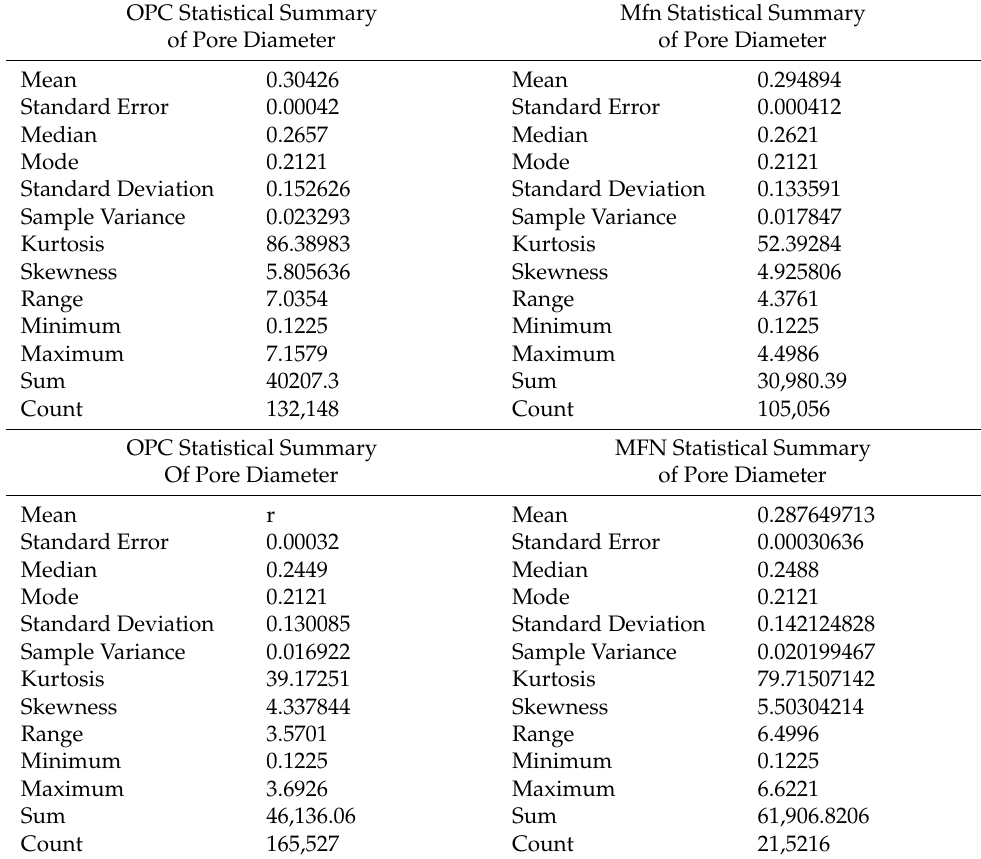
Figure A6. Frequency of the pore diameters in the mortar samples at 28 days age. Table A1. Statistical summary of pore diameters.